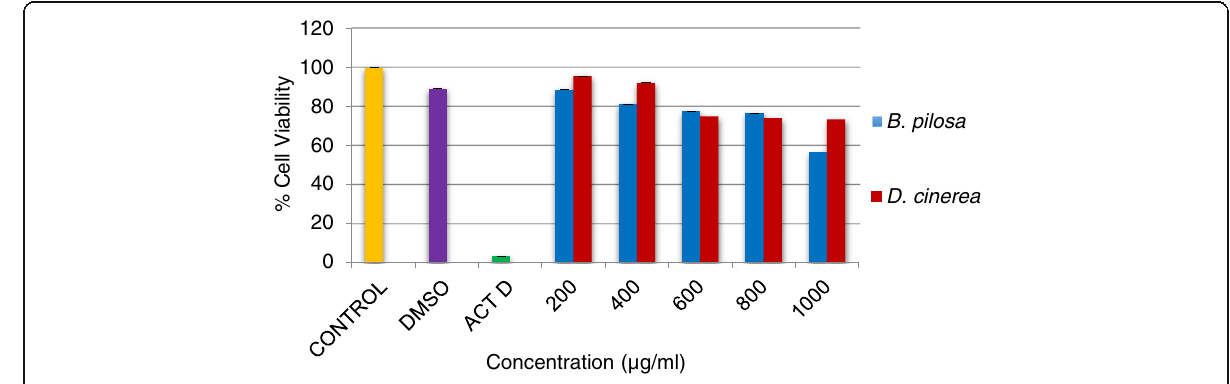
Fig. 5 The cytotoxic effects of B. pilosa and D. cinerea extracts against